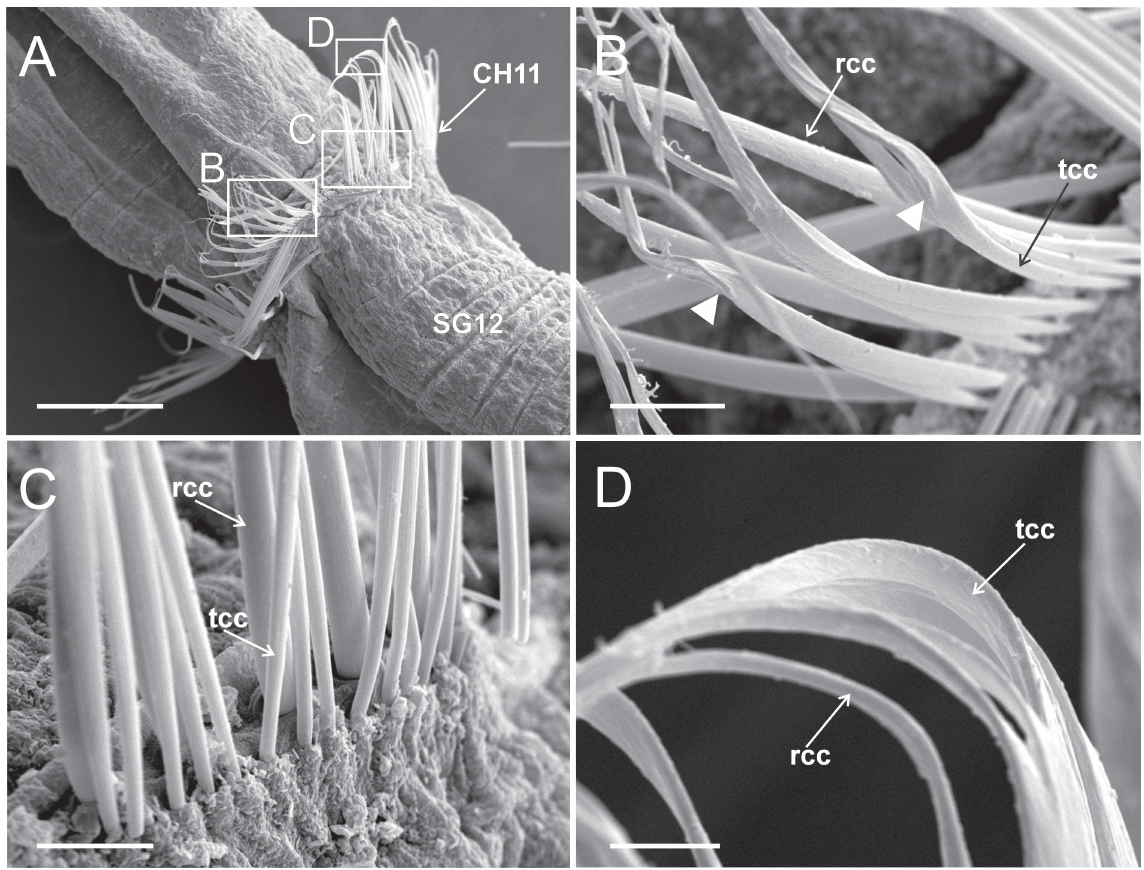
Fig. 7. Heterospio indica sp. nov., paratype (MNCN 16.01/17000), SEM micrographs. A . Elongated SG12, CH11 and flange-like neuropod, framed areas showing chaetal details in (B), (C) and (D) (scale bar = 100 m m). B . Detail of CH11 chaetae, arrowheads showing start of opening end in thin capillary chaetae (scale bar = 10 m m). C . Detail of proximal part of both types of CH11 capillary chaetae, anterior body end at left (scale bar = 10 m m). D . Detail of distal part of capillary chaetae (scale bar = 5 m m). Abbreviations: CH = chaetiger; rcc = robust capillary chaetae; SG = segment; tcc = thin capillary